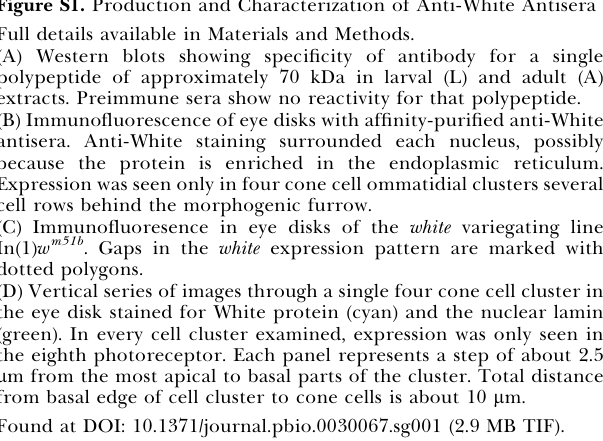
Figure S1. Production and Characterization of Anti-White Antisera Full details available in Materials and Methods. (A) Western blots showing specificity of antibody for a single polypeptide of approximately 70 kDa in larval (L) and adult (A) extracts. Preimmune sera show no reactivity for that polypeptide. (B) Immunofluorescence of eye disks with affinity-purified anti-White antisera. Anti-White staining surrounded each nucleus, possibly because the protein is enriched in the endoplasmic reticulum. Expression was seen only in four cone cell ommatidial clusters several cell rows behind the morphogenic furrow. (C) Immunofluoresence in eye disks of the white variegating line In(1) w m51b . Gaps in the white expression pattern are marked with dotted polygons. (D) Vertical series of images through a single four cone cell cluster in the eye disk stained for White protein (cyan) and the nuclear lamin (green). In every cell cluster examined, expression was only seen in the eighth photoreceptor. Each panel represents a step of about 2.5 l m from the most apical to basal parts of the cluster. Total distance from basal edge of cell cluster to cone cells is about 10 l m. Found at DOI: 10.1371/journal.pbio.0030067.sg001 (2.9 MB TIF). Figure S2. Comparison of Different Cell Populations Based upon Time after Differentiation or Cell Cycle Arrest Individual rows of differentiated nuclei were compared to one another to see whether differences in interaction levels existed between younger and older cells. (A–C) Row-by-row analysis method for lines bw D , In(1) rst 3 , and In(3L)BL1 respectively. Each color represents a different row, rows 4– 8 respectively. (D–F) Scattergrams for each row based on pooling of data from three different disks per line. Y-axis is distance in microns; X-axis is row number. (G–I) Percentile plots of each row. Table S1. Variegating Locus-to-Heterochromatin Distances in Wild- Type Cells and Random Distributions Found at DOI: 10.1371/journal.pbio.0030067.st001 (53 KB DOC). Table S2. Effects of Nuclear Dimensions on Variegating Gene-to- Heterochromatin Distances Found at DOI: 10.1371/journal.pbio.0030067.st002 (40 KB